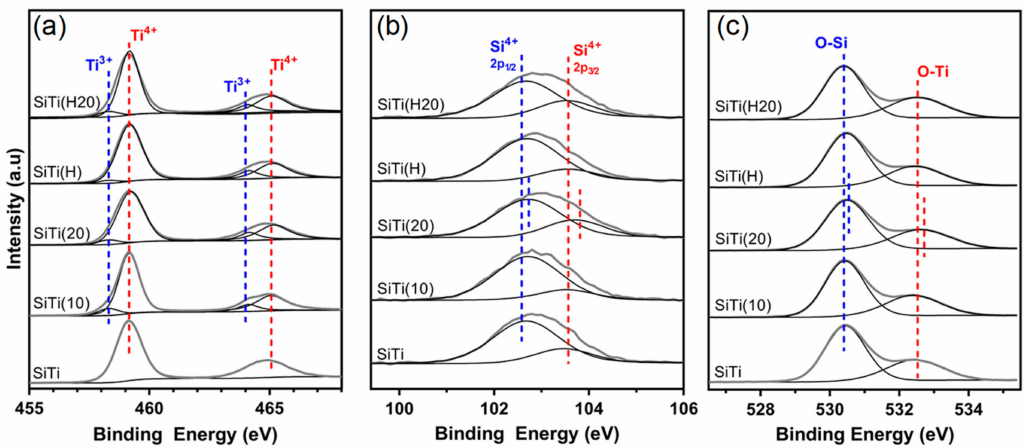
Figure 5. ( a ) Ti2p, ( b ) Si2p, and ( c ) O1s XPS spectra of the neat SiTi and hydrogenated SiTi(H) after plasma treatment for 10 and 20